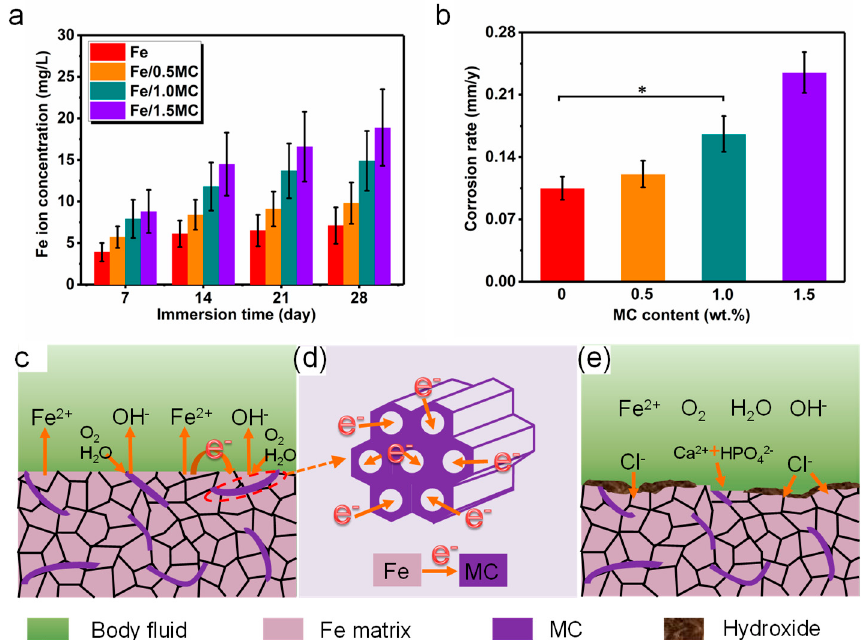
Figure 8. ( a ) Fe ion concentrations released from the Fe/MC composites after immersion for 7, 14, 21, and 28 d, n = 3, * p < 0.05; ( b ) Calculated degradation rate basing on immersion tests; ( c ) Initial corrosion stage caused by galvanic corrosion; ( d ) Local enlarged drawing of electron transfer between galvanic couple; ( e ) Corrosion products precipitated on surface.